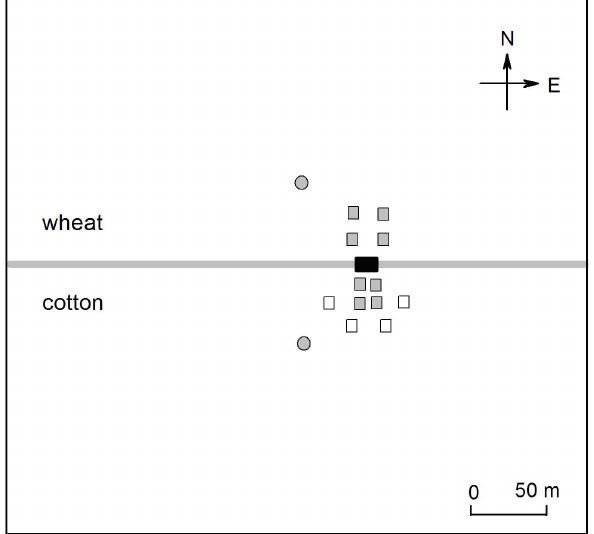
Fig. 1. Layout of the experimental site. The horizontal course line indicates the path dividing the experimental area into the cotton (north) and wheat (south) fields. The grey circles, grey squares, and empty squares indicate the locations of the eddy covariance towers, automatic chambers, and the manual chambers, respectively. The black rectangle indicates the location of the temporary